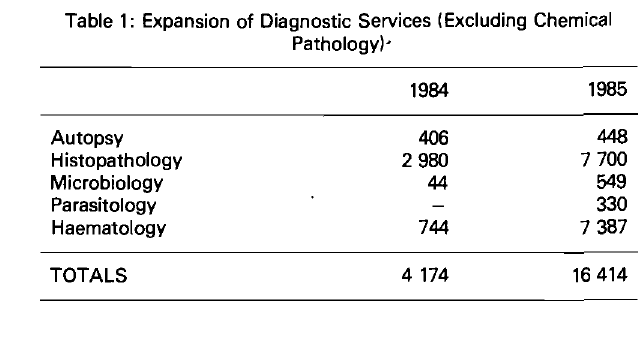
Fig. 4: Numbers of patients treated per month 1983 - 1985 The faculty operates an outpatient clinic, hospitalisa tion of patients and an ambulatory service at subsidised cost to indigent members of the community. In addi tion, 918 patients were treated at an outlying clinic at Maboloka in the Republic of Bophuthatswana during 1985. An ongoing herd health programme on farms en sures adequate access to farm livestock.